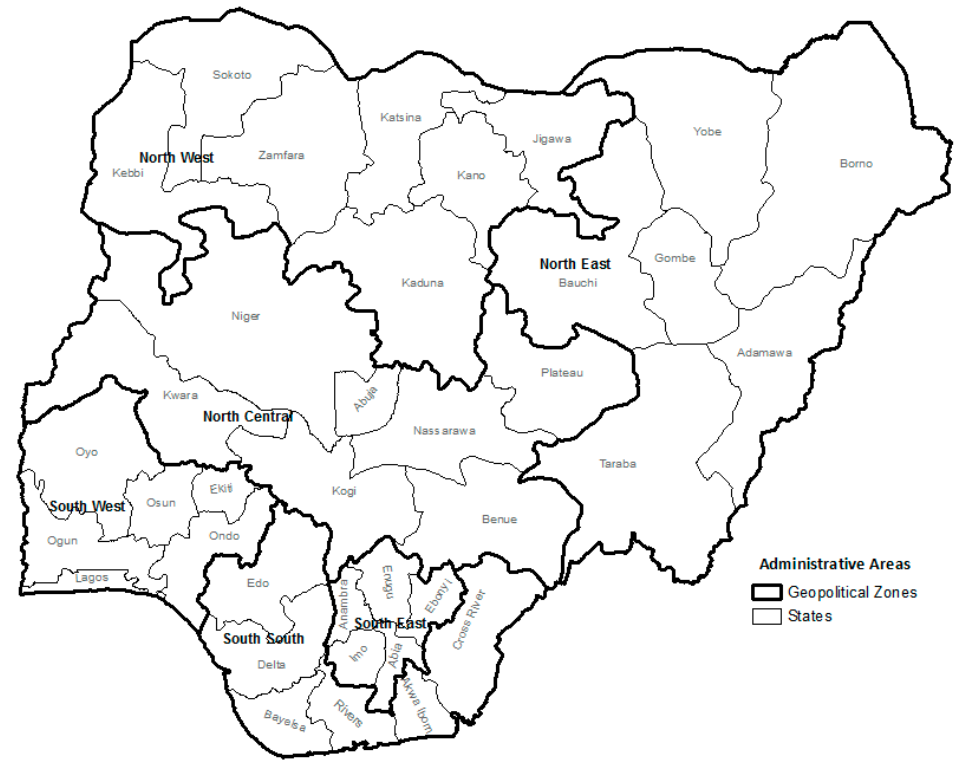
Figure 1 . Map of Nigeria showing key administrative boundaries.